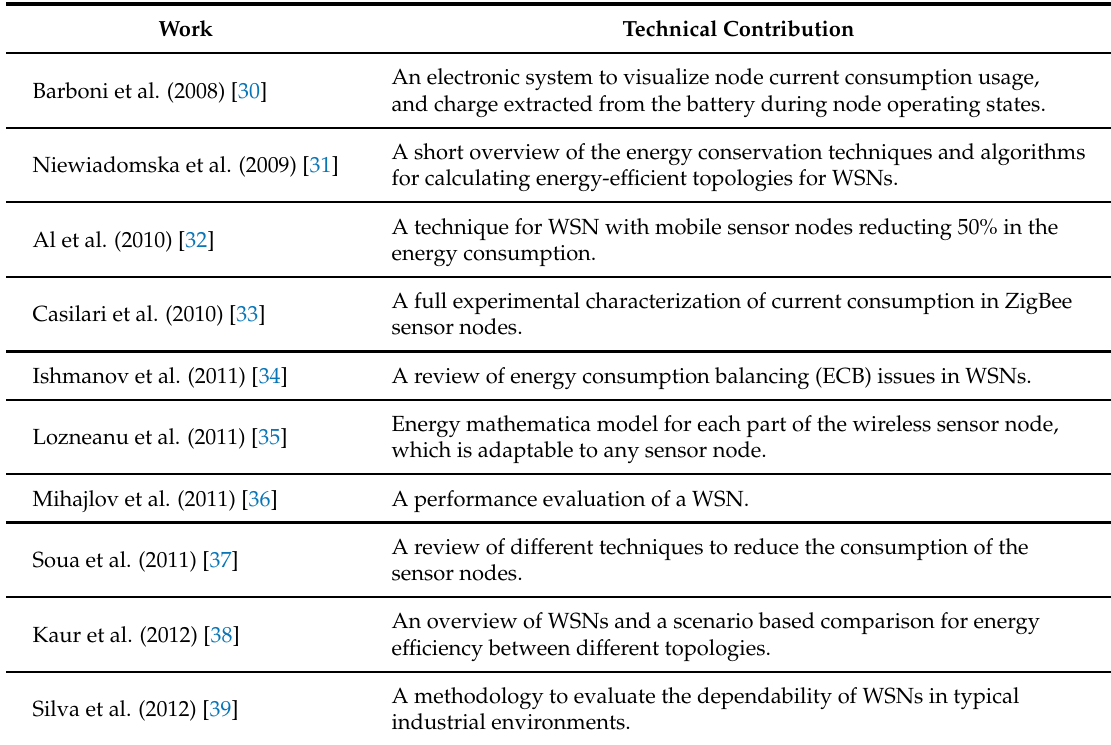
Table 1. State of the art of relevant works in WSN literature related with energy aspects. Work Technical